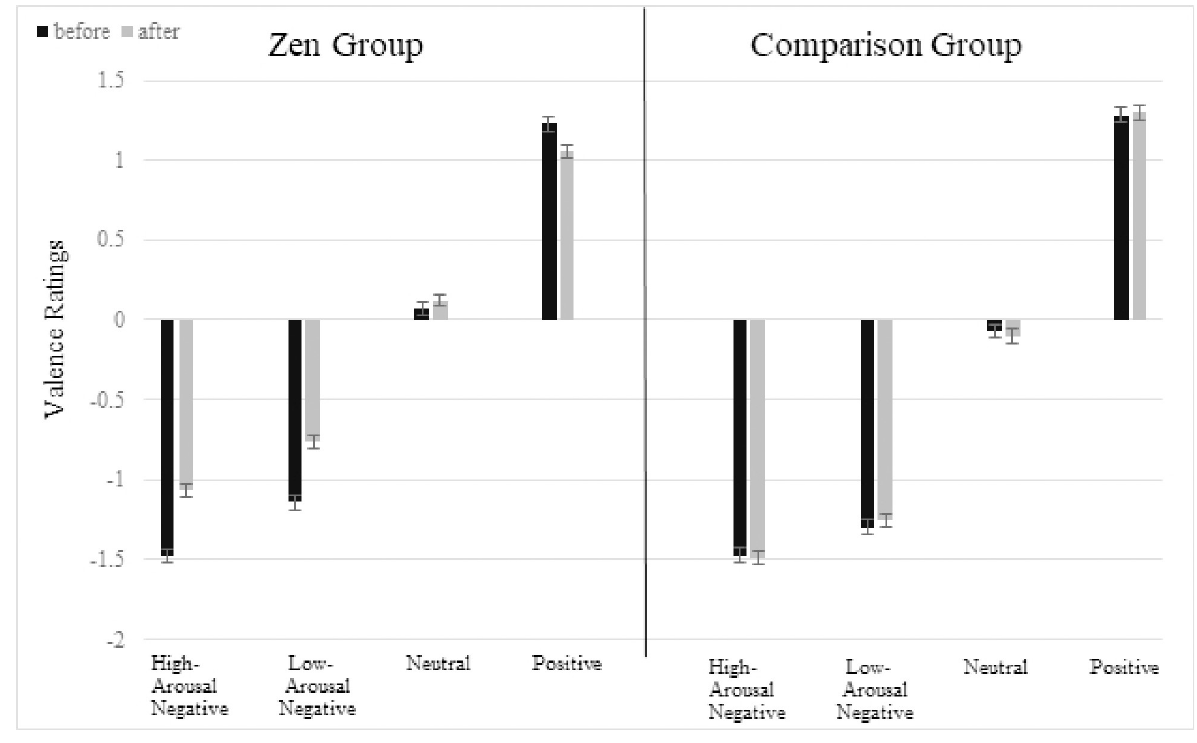
Fig 2. Valence rating results. Error bars indicate standard errors.